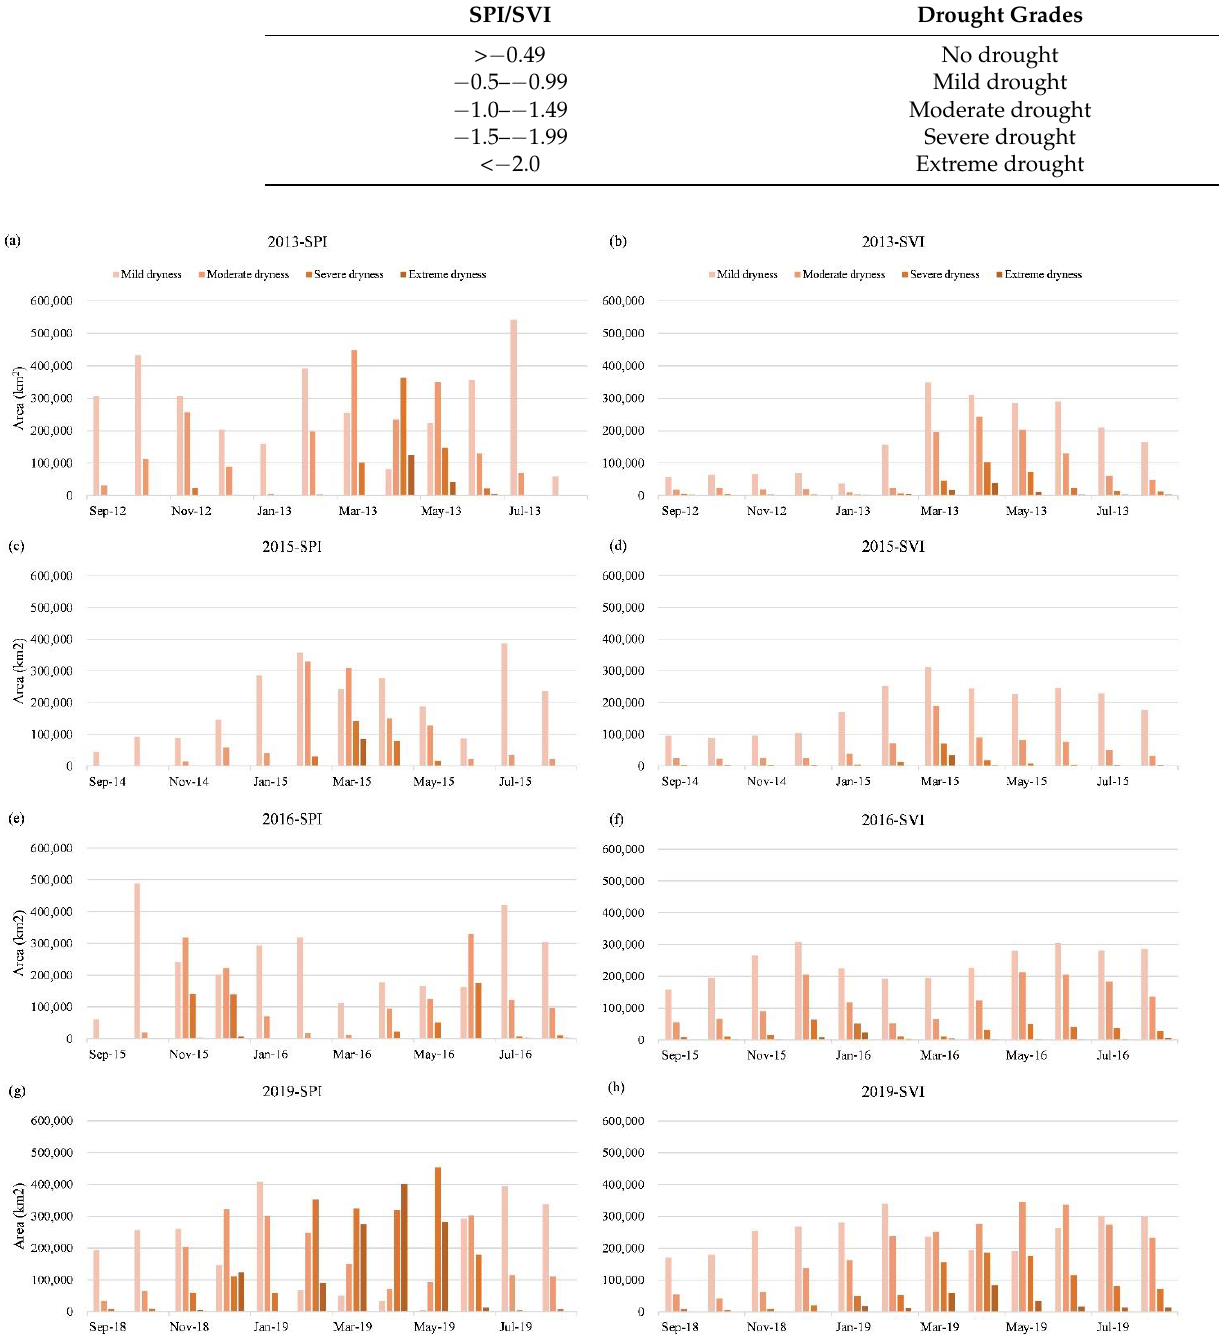
Figure 7. SPI/SVI drought area statistics map of three drought events in Namibia: ( a ) Monthly drought area evolution of SPI, 2013; ( b ) Monthly drought area evolution of SVI, 2013; ( c ) Monthly drought area evolution of SPI, 2015; ( d ) Monthly drought area evolution of SVI, 2015; ( e ) Monthly drought area evolution of SPI, 2016; ( f ) Monthly drought area evolution of SVI, 2016; ( g ) Monthly drought area evolution of SPI, 2019; ( h ) Monthly drought area evolution of SVI, 2019.